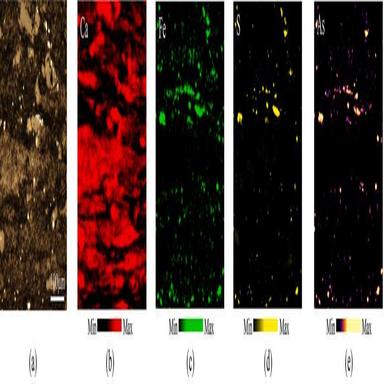
(a) Optical camera image of the 500 μm × 500 μm area (EFS1) from the Eagle Ford shale thin section. (b–e) Four of the eight element intensity maps (calcium, iron, sulfur and arsenic) of EFS1 with a 2 μm resolution.